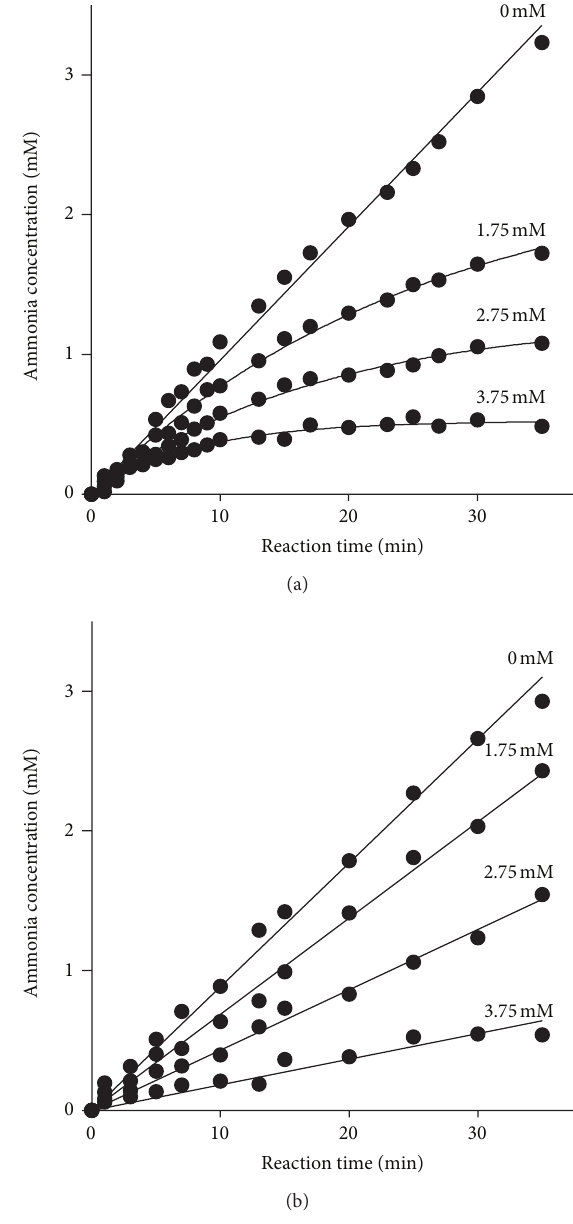
Figure 4: (a) Reaction progress curves of urease-catalyzed hydrol- ysis of urea in the presence of BA. (b) Steady-state analysis: concentration of ammonia versus time. BA concentration (mM) is numerically